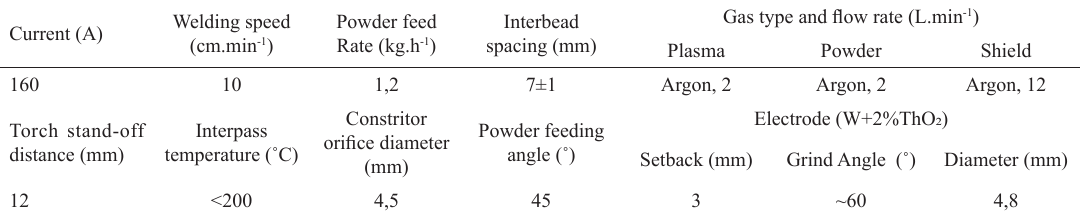
Table 1: PTA hardfacing parameters used to process the coatings on AISI 304 substrates Welding speed Current (A) (cm.min -1 )